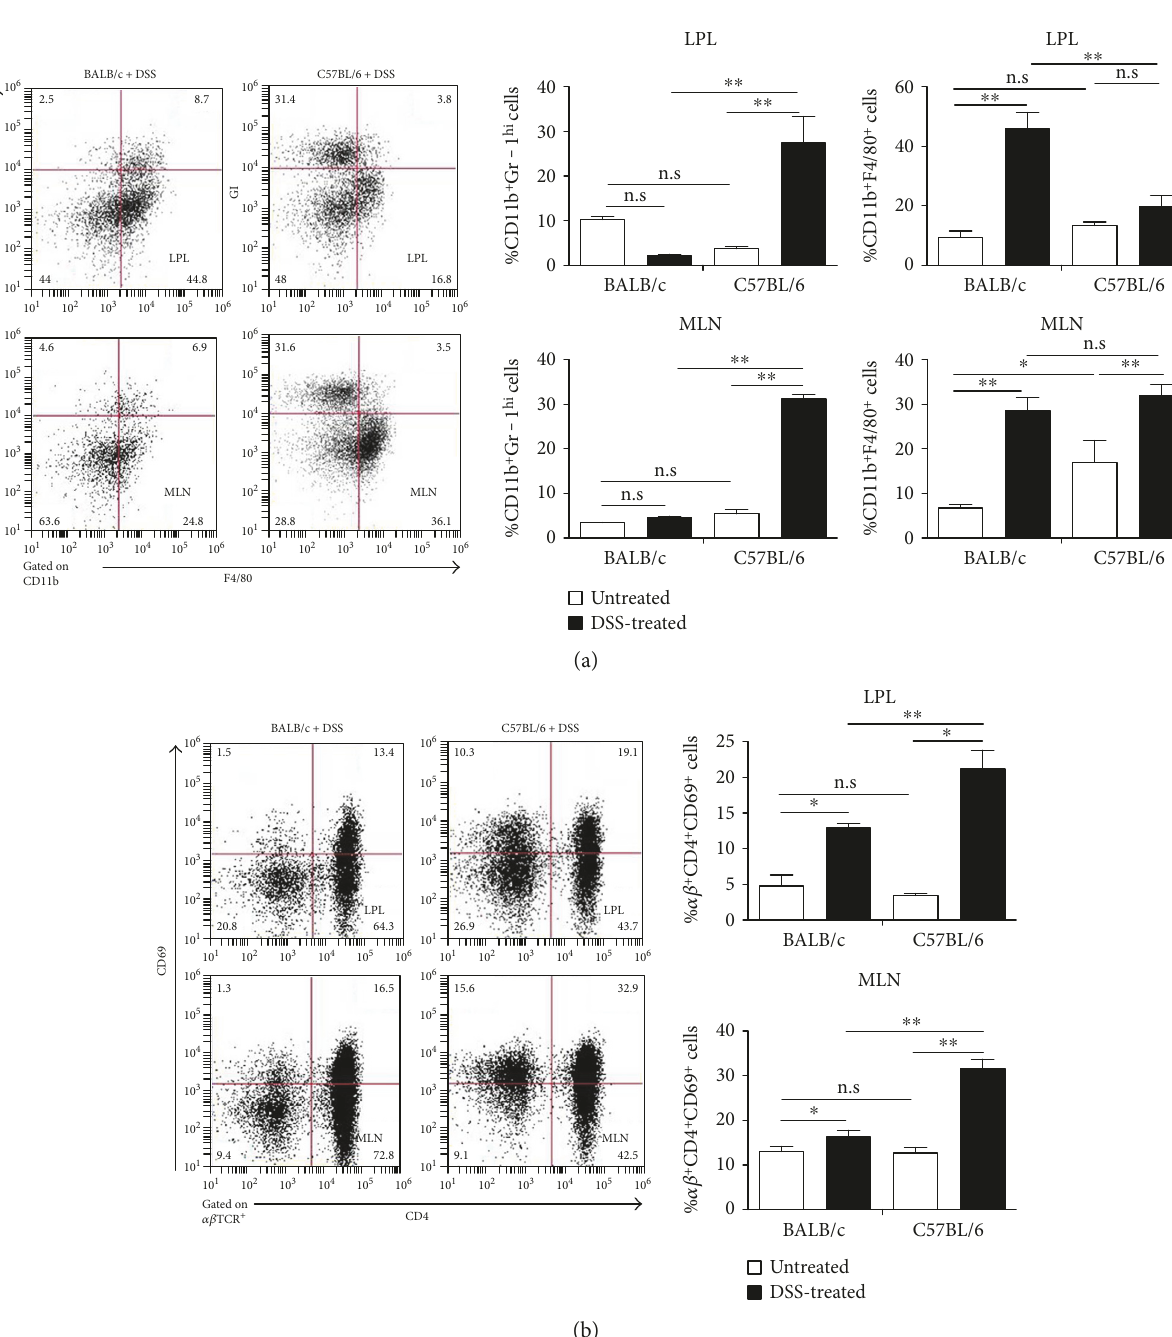
Figure 3: Lymphocyte subsets of LPL and MLN in DSS-challenged BALB/c and C57BL/6 mice as measured by FACS. Data indicate the mean ± SD of three animals, representative of two independent experiments. Statistical signi fi cant di ff erences were evaluated by Student ’ s t -test. ∗ p < 0 05 ; ∗∗ p < 0 01 . The mononuclear cells were harvested from LP and MLN 6 days after DSS induction and strained with various combinations of mAbs (neutrophil: CD11b + Gr-1 high ; monocyte: CD11b + F4/80 + ; activated T cells: CD4 + TCR αβ + CD69 + ). In all assays, the physical (day 0) cell number of immune cell subtypes is 200,000/sample. (a), (b) The isotype stainings were performed using a di ff erent fl ow cytometer and thus cannot be directly compared and hence are not